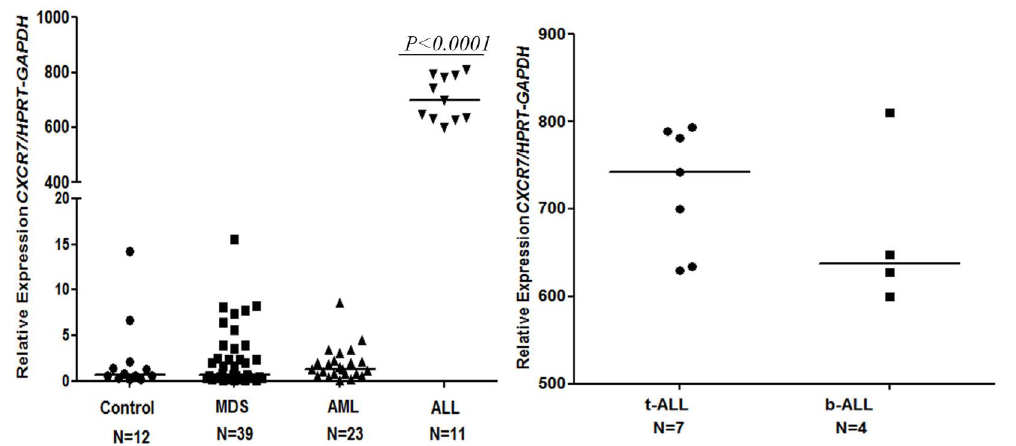
Figure 2. CXCR7 has higher expressed in ALL. Quantitative expression of CXCR7 mRNA in patient cells relative to healthy donor cells and among different patient groups. Real time RT-PCR was performed on cDNA from the samples of patients with hematopoietic malignancies or from bone marrow samples from healthy donors. Each dot indicates the relative CXCR7 expression for each patient. Horizontal lines represent medians. mRNA expression levels of CXCR7 were normalized by HPRT and GAPDH endogenous control. A) CXCR7 mRNA was highly upregulated in BM samples from ALL patients compared to normal hematopoietic cells samples ( P , 0.0001 ) and to MDS and AML patients samples ( P , 0.0001 ). There was no significant difference in CXCR7 expression among patients with MDS, AML, and normal hematopoietic cells. B) Among ALL-diagnosed patients, CXCR7 expression was more pronounced in the T-ALL subtype; Mann-Whitney test.